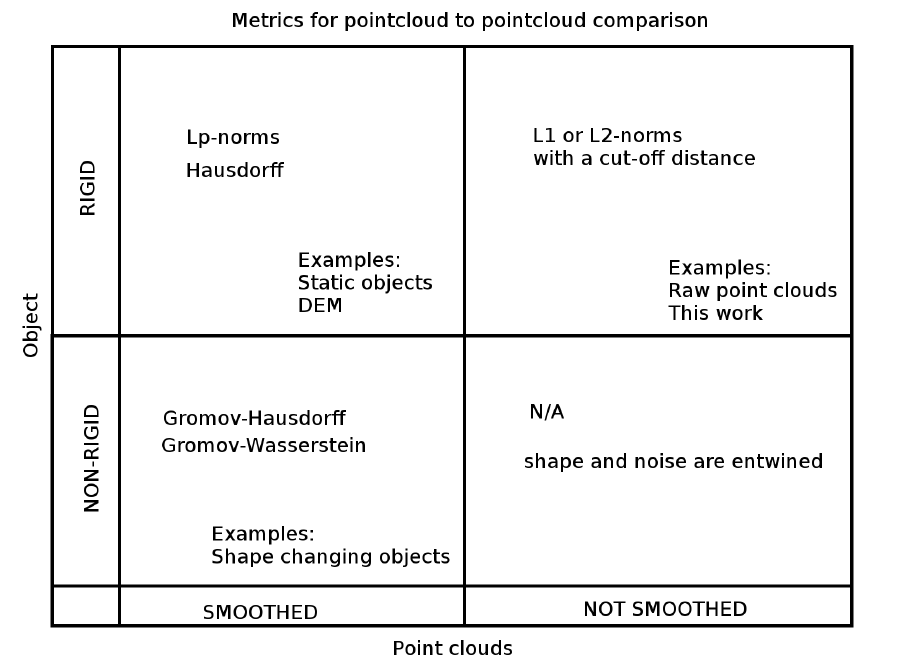
Figure 1. Metrics for point cloud to point cloud comparison. In this work, the focus is on the comparison of as-is point clouds captured from rigid environments. DEM stands for digital elevation models. See the text in Section 2.3 for the